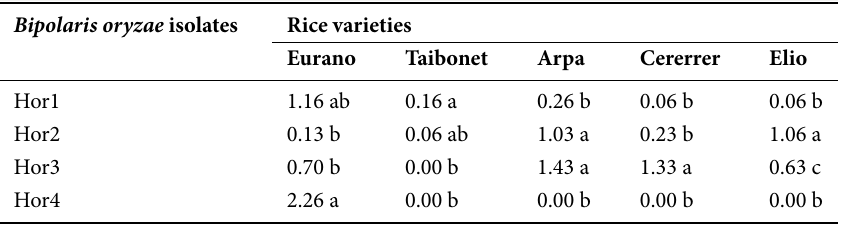
Table 8 Sporulation of the four isolates of Bipolaris oryzae on the leaves of the five varieties of rice (×10 5